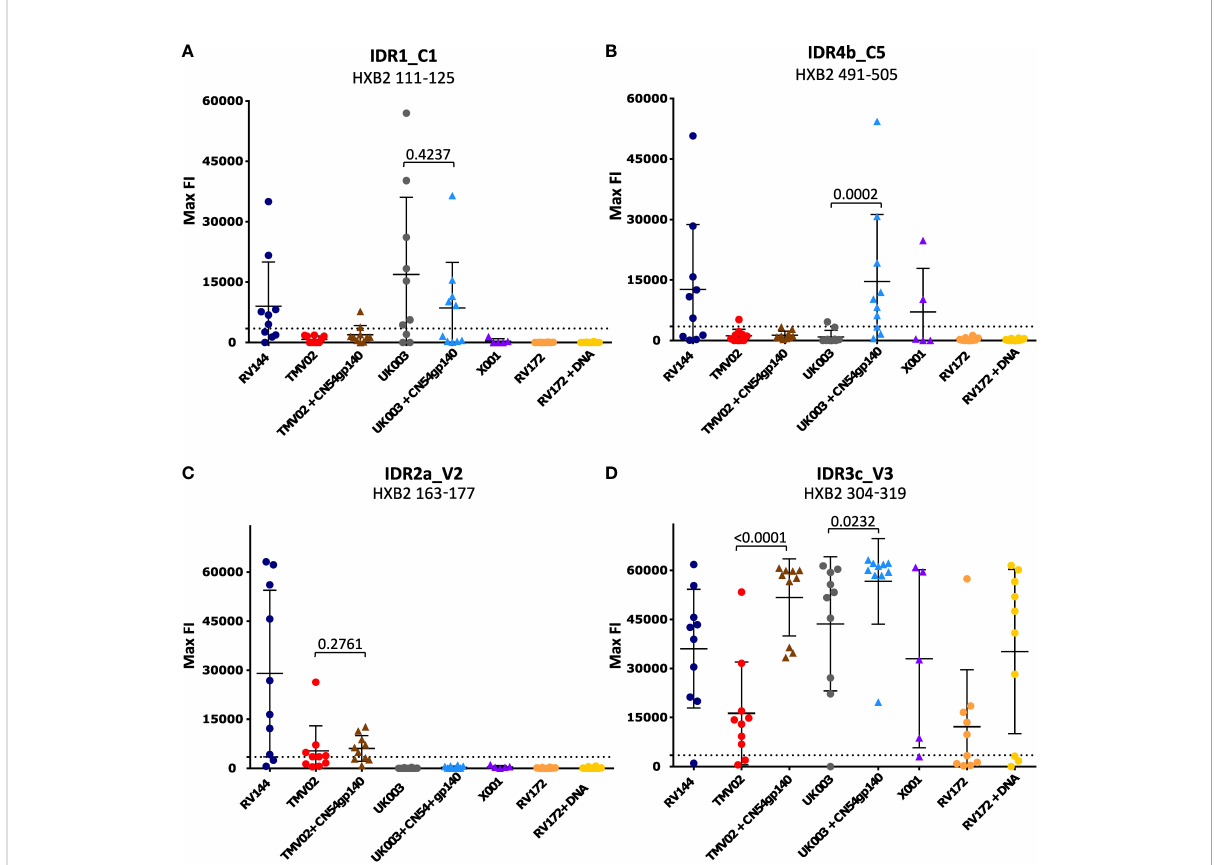
FIGURE 3 Statistical comparison of IgG responses targeting single peptide IDRs. Graphs (A-D) each depict the statistical comparison of the FI values of one representative peptide of the 4 IDRs. Each symbol indicates the maximum FI value of one single study participant. Values after subtraction of the baseline are shown. The cut-off for positive signals is indicated by a dotted line. P-values were calculated using a Mann-Whitey-U test. P-values of comparisons between groups with or without CN54gp140 protein boosts are shown. Triangular symbols indicate that the CN54gp140 protein was part of the study ’ s vaccination schedule, round symbols represent vaccinees that did not receive the CN54gp140